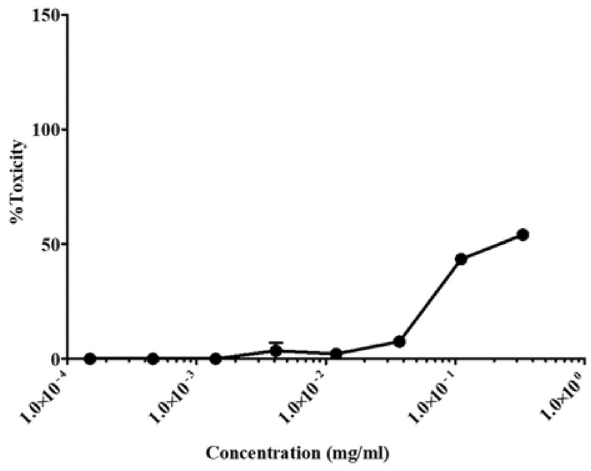
Figure 2. Evaluation of the PHELA extract cytotoxicity in 293-T ACE.MF cells. The extract was incubated with 293T-ACE.MF cells for 72 h followed by the determination of cytotoxicity using the MTT assay. Data shown are means ± standard deviation of three independent experiments.